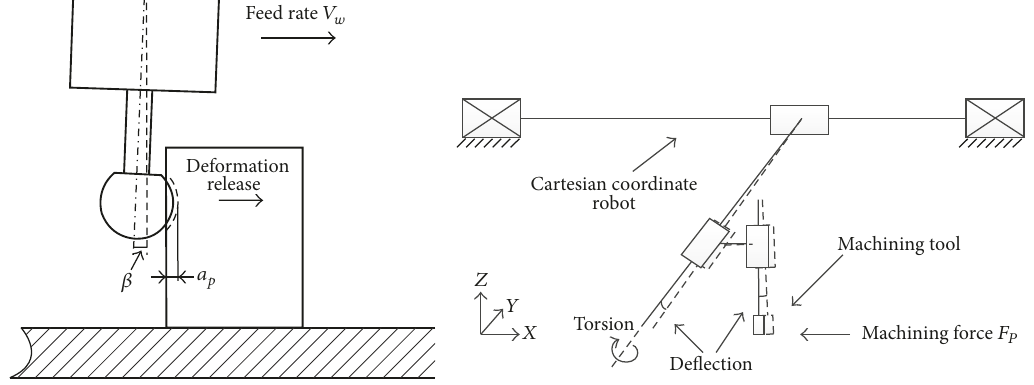
Figure 1: Generation of cutting deformation.